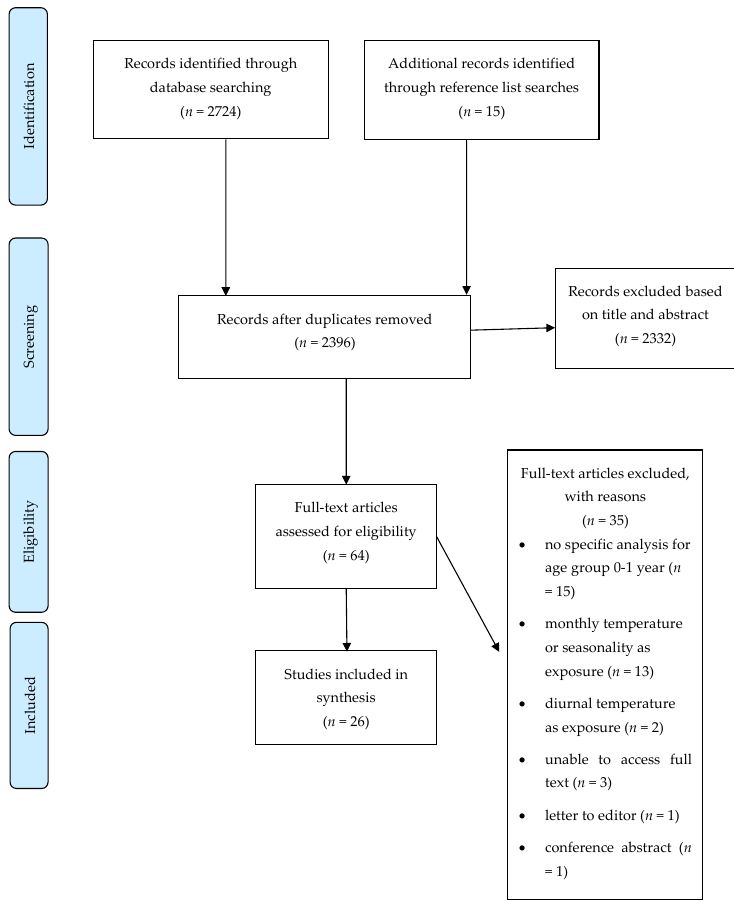
Figure 2. PRISMA flow diagram that illustrates the study selection process